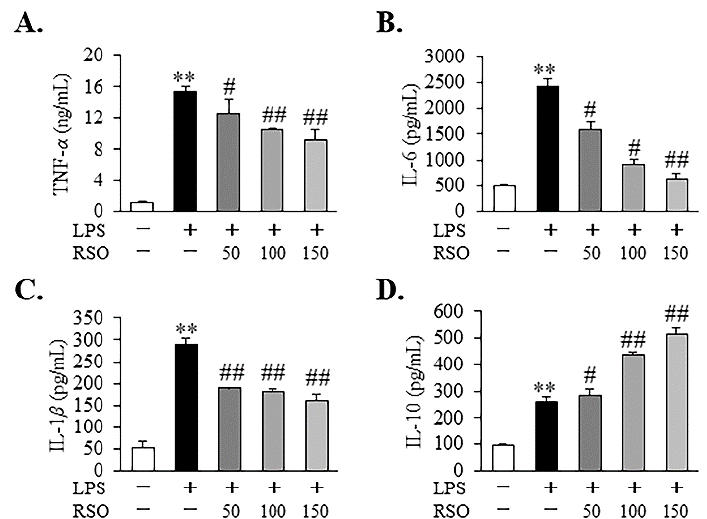
Figure 5. Effect of RSO on inflammatory cytokine content of LPS-induced RAW 264.7 cells. ( A ) TNF- α contents of each group; ( B ) IL-6 contents of each group; ( C ) IL-1 β contents of each group; ( D ) IL- 10 contents of each group, n = 3. ** p < 0.01 vs control group; # p < 0.05, ## p < 0.01 vs LPS-induced group.